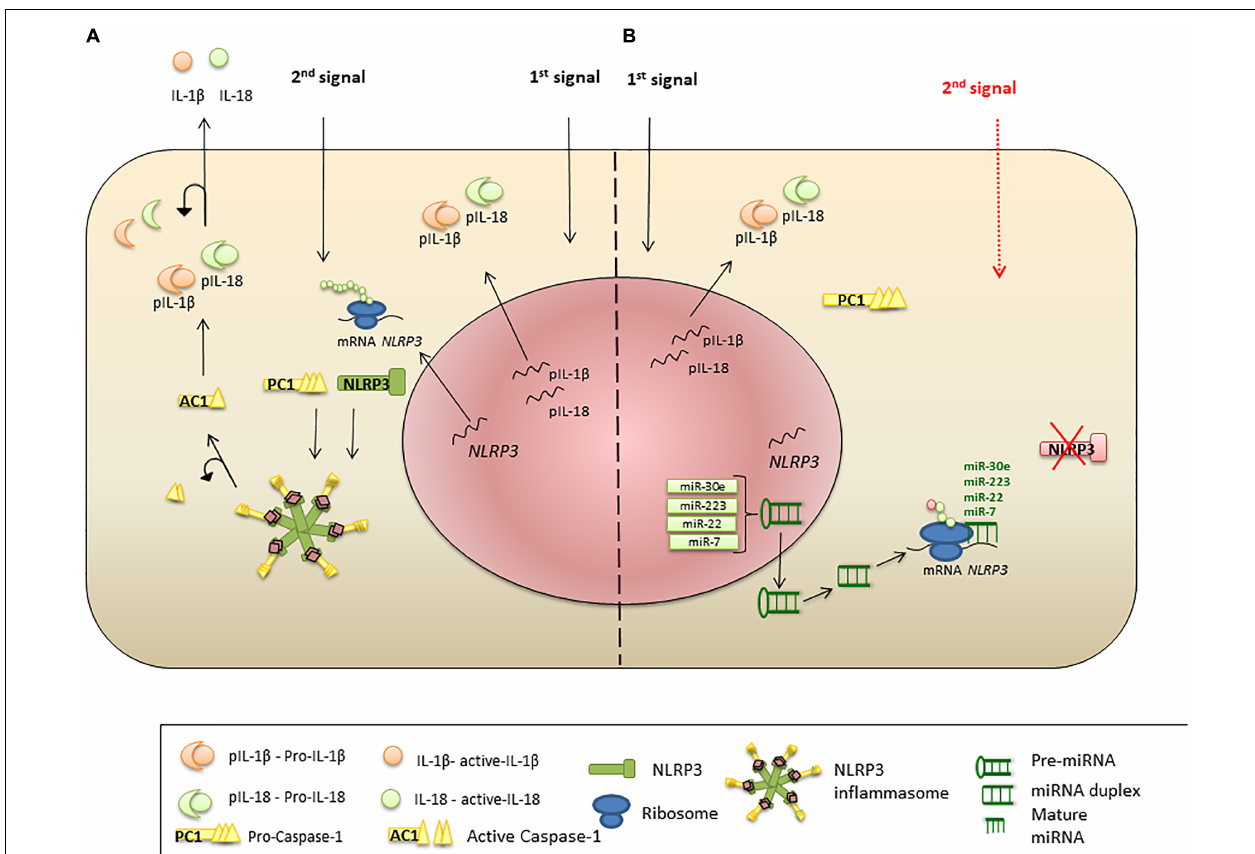
FIGURE 2 | miRNA regulation of NLRP3 inflammasome expression. (A) Priming signal triggers NLRP3, PC1, IL-1 β , and IL-18 transcription and protein synthesis. Activation signal initiates inflammasome formation and release of AC1. AC1 proteolytically cleaves pro-IL-1 β and pro-IL-18, liberating active cytokines. (B) Suppression of NLRP3 protein translation and inflammasome formation by miRNA. Priming stimulus triggers NLRP3 transcription; however, miR-223 , miR-22 , miR-30e , and miR-7 bind to the UTR region of NLRP3 mRNA and interrupt protein translation. Absence of NLRP3 protein leads failure of the inflammasome protein complex formation, when the second stimulus